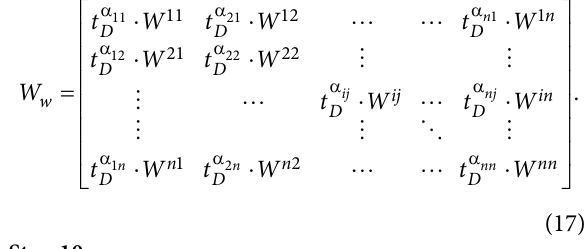
Calculation of limited supermatrix. Limited